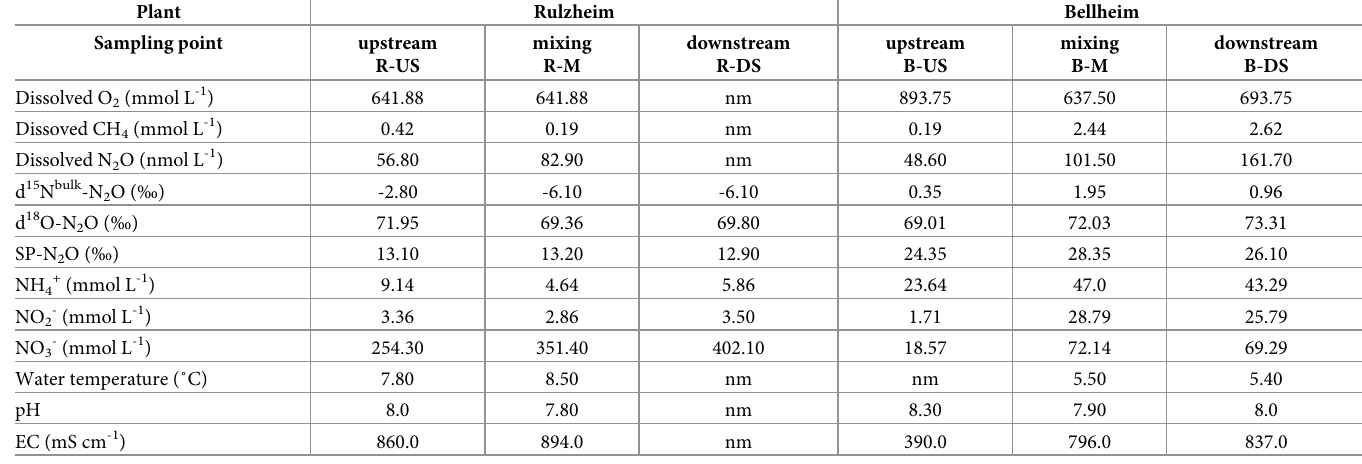
Table 1. Summary of measured parameters in the receiving streams before effluent addition (upstream, US), at the mixing point (M) and downstream (DS) of the WWTP.